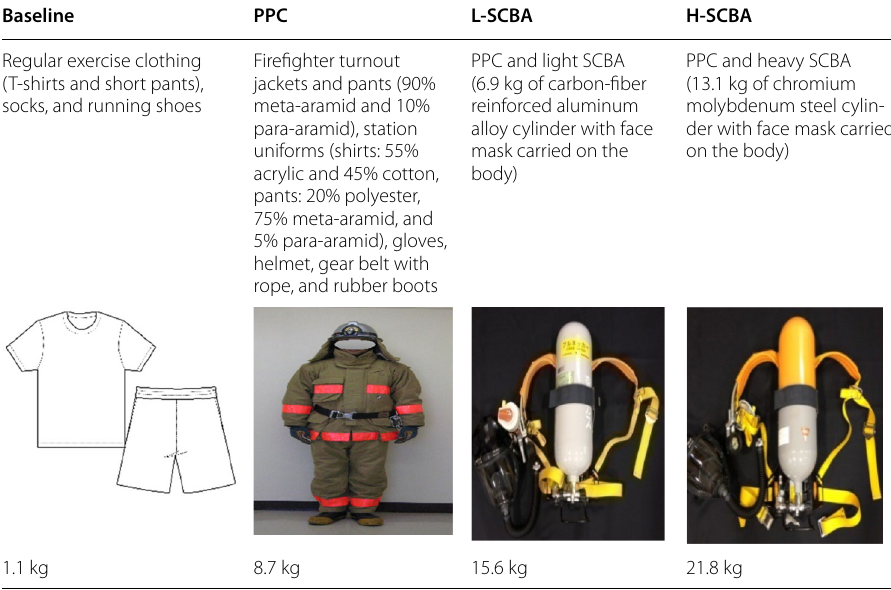
Table 1 Comparison of clothing conditions Baseline Regular exercise clothing (T‑shirts and short pants), socks, and running